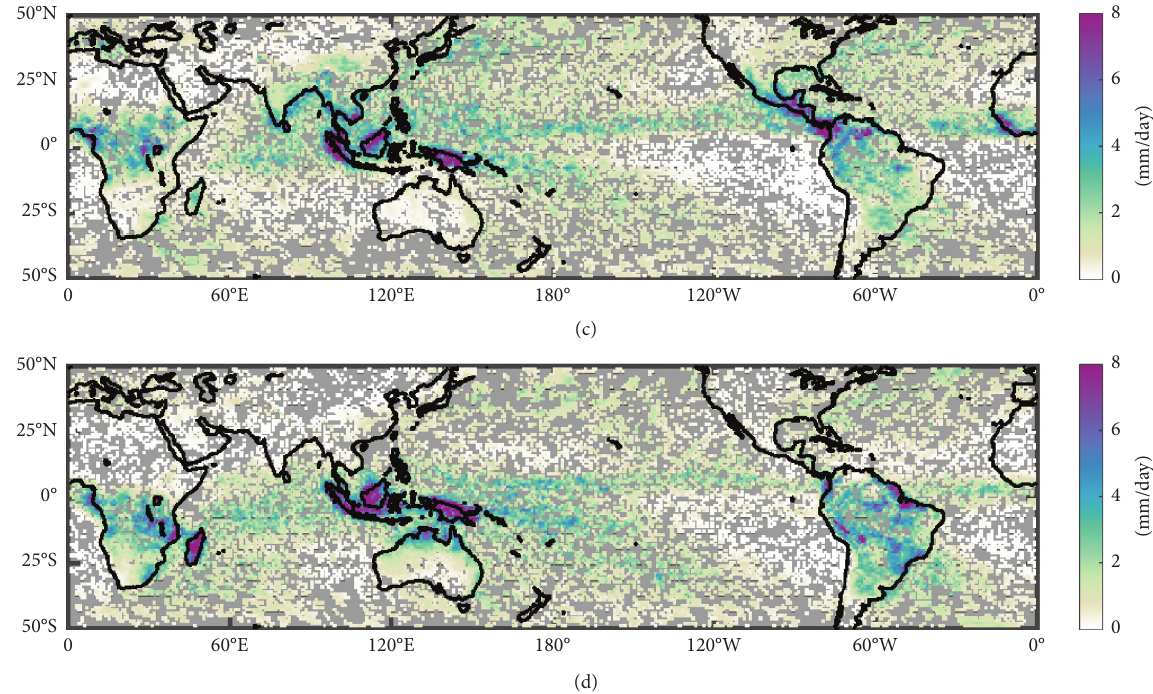
Figure 5: Amplitude of the diurnal harmonic from the IMERG V06B product in (a) MAM; (b) JJA; (c) SON; and (d) DJF. The grey shadowing represents that the diurnal harmonics were not statistically significant at the 90% confidence